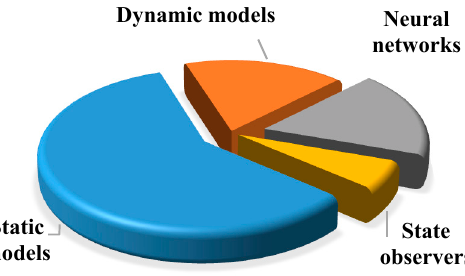
Figure 1. Pie chart arising of the state of art of techniques for the estimation of the